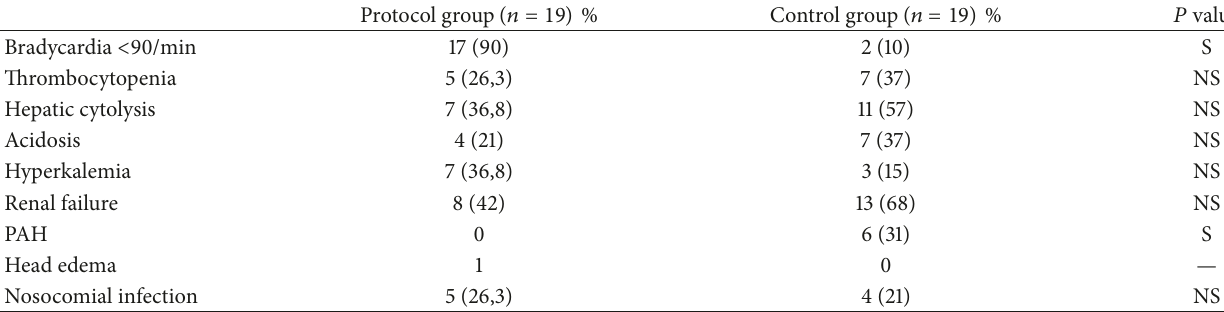
Table 3: Complications during hospitalization.